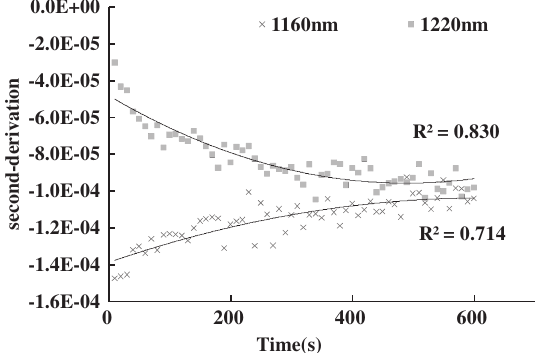
Fig. 7. Variations of bulk and bound water with pressure duration.